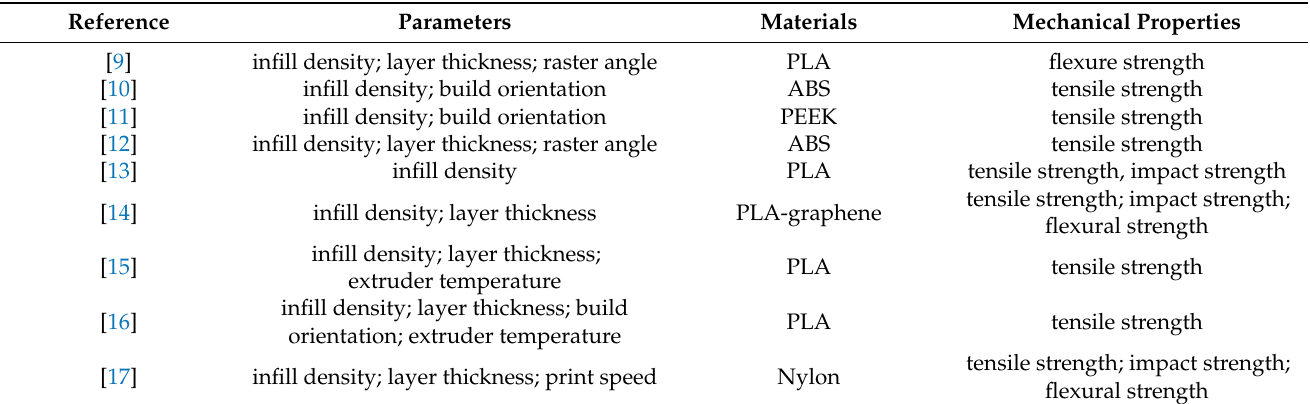
Table 1. Summary of previous literature related to infill